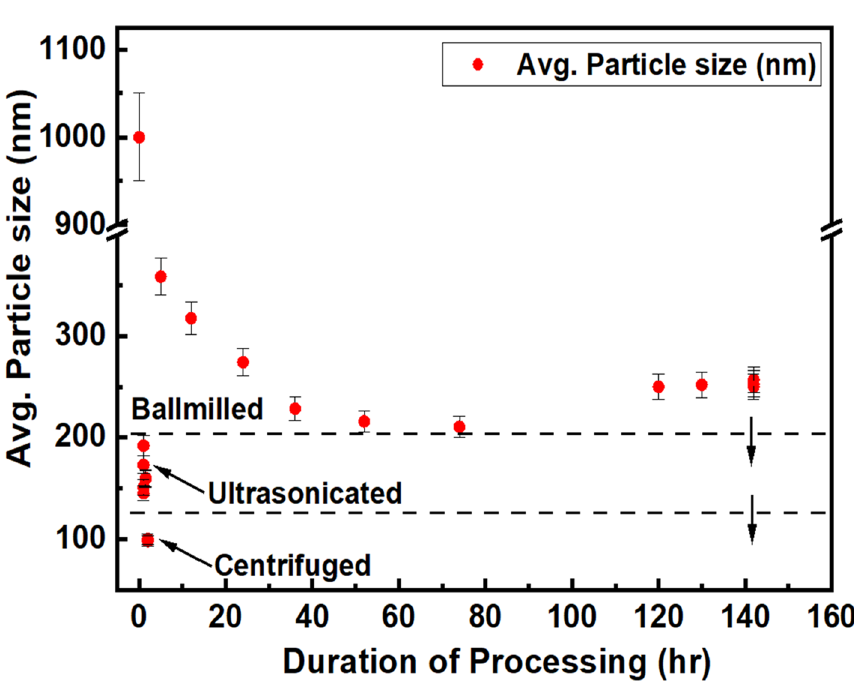
Figure 3. Particle size reduction of ChGs by combining ball-milling, ultrasonication, and centrifugation,